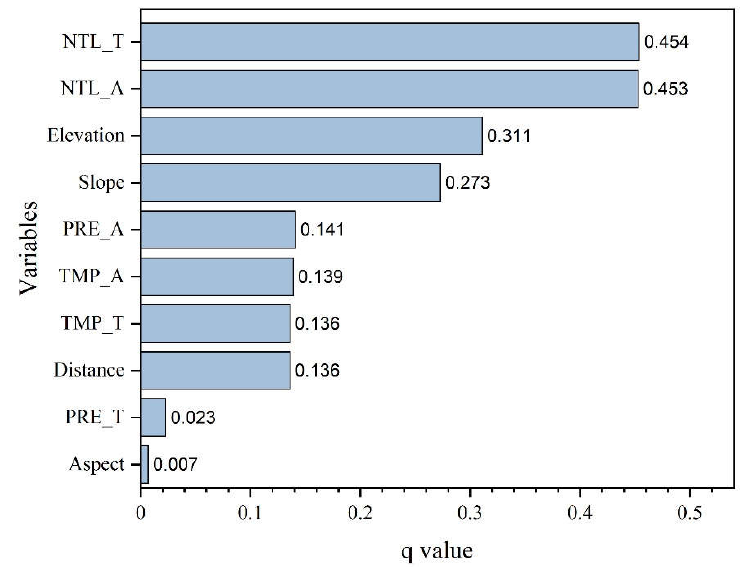
Figure 5. Relative importance of driving factors.